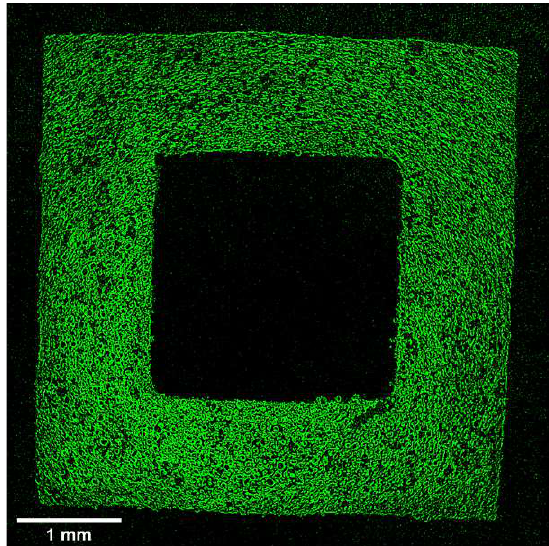
Figure A2. Cross-sectional X-ray tomography image of a 3D-printed hollow cubic carbon structure.